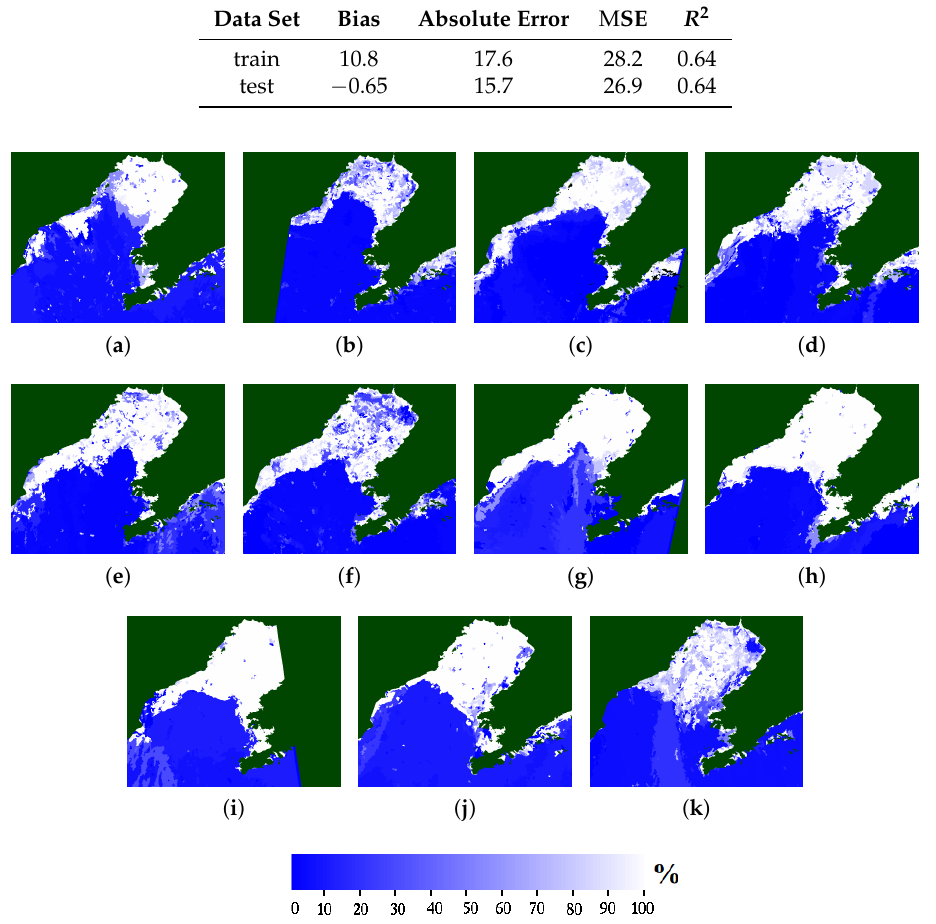
Figure 13. MLP-based ice concentration estimates for the RADARSAT-2 SAR imagery, presented